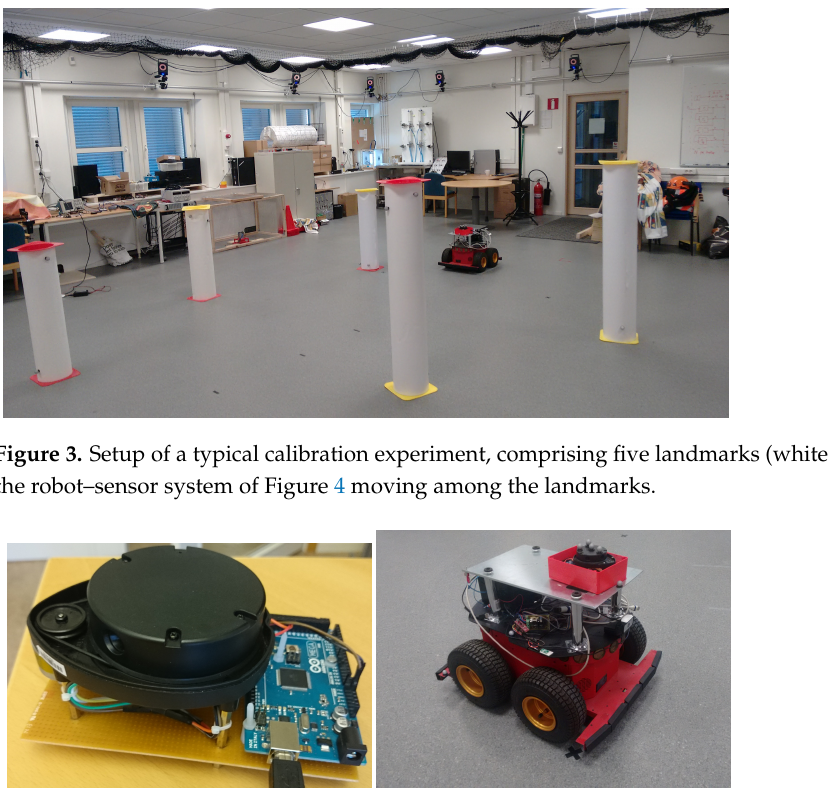
Figure 3. Photo of a mobile robot with a triangulation lidar mounted on its top.